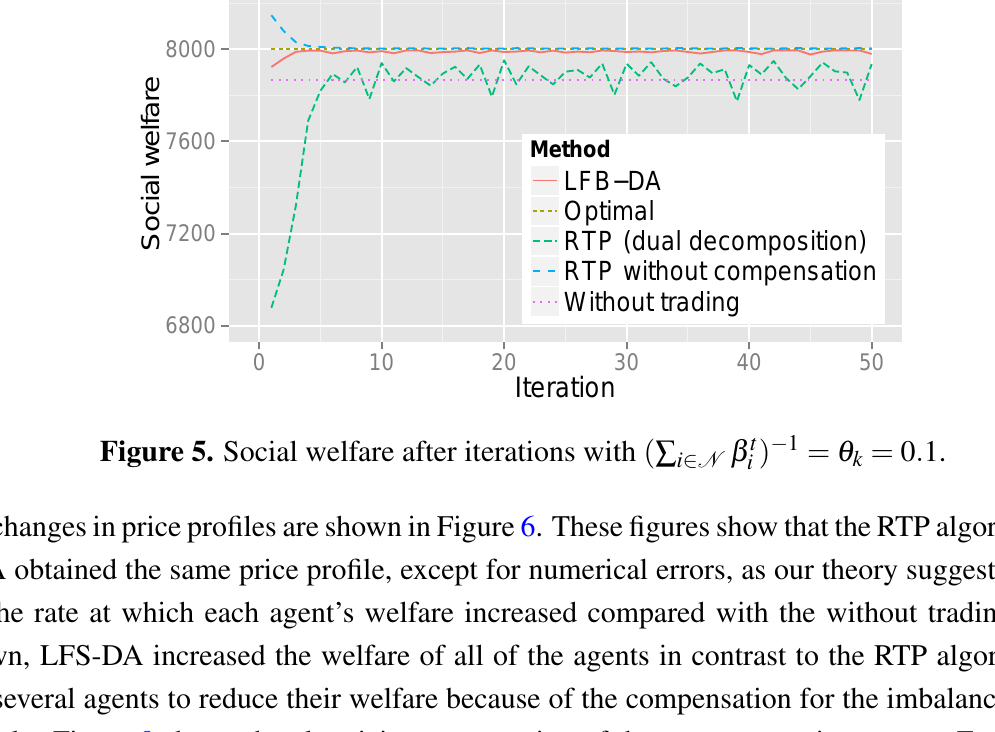
Figure 5. Social welfare after iterations with ( ∑